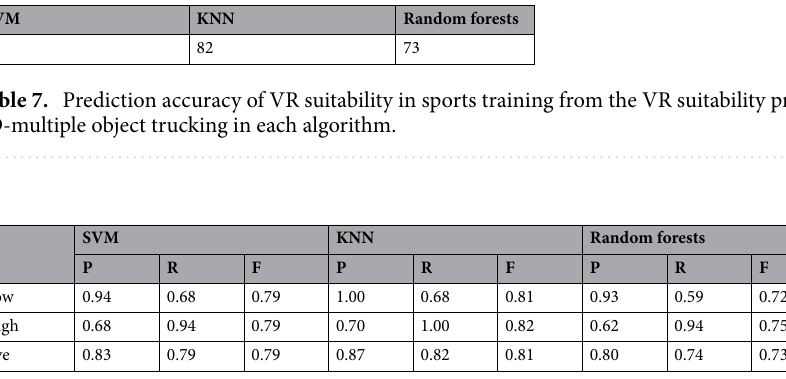
Table 8. The precision, recall rate, and F-values of VR suitability in sports training from the VR suitability predictor by 3D-multiple object trucking in each algorithm. P precision, R recall rate, F F value.